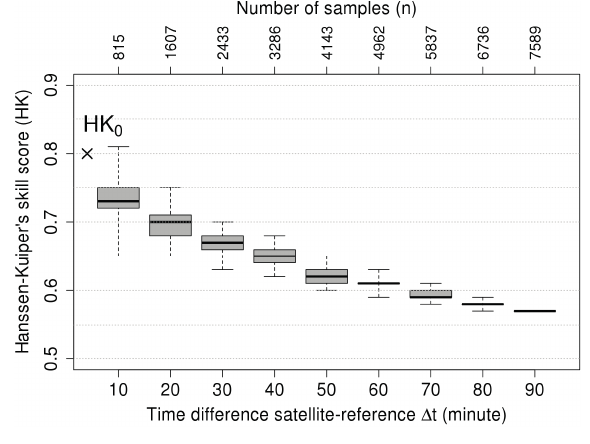
Figure 3. An example of the validation results at Payerne for the degraded time series (deg p = 1 ° %, s = 3h ) for a different maximum time difference between the NOAA/AVHRR overpass and reference SYNOP observation ( Δ t ). Each boxplot contains 500 values derived from the random selection of n samples from the total number of overpasses ( N = 7589). The unbiased skill score (HK 0 ) is marked with ×. The boxes contain the median (thick line), their bottom and top identify the 1 st and 3 rd quartiles, and the whiskers extend to the data